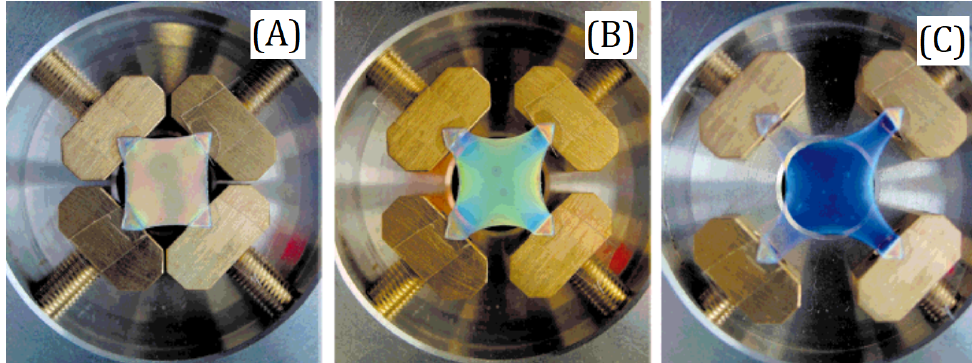
Figure 14. Colour shift observed for cholesteric liquid crystal elastomer as a function of strain. The colour change is observed due to change in the position of the reflection band of the elastomer as a function of mechanical deformation with unstrained sample ( A ) being green through to ( B ) light green, with blue in the corners, to strained sample ( C ), where the entire sample is blue. Reprinted with permission from Finkelmann et al., Advanced Materials , 2001 , 13 ,